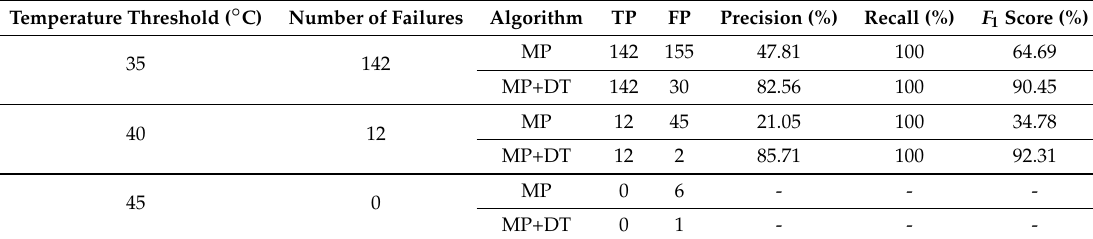
Table 1. Summary for failure identification